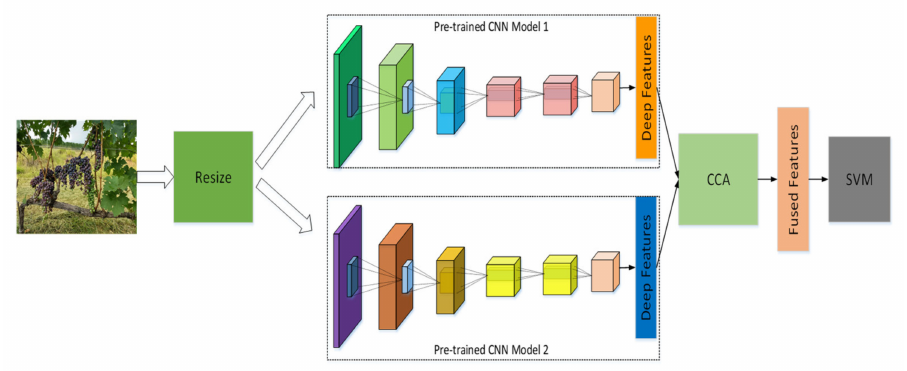
Figure 6. The processing flow of the proposed